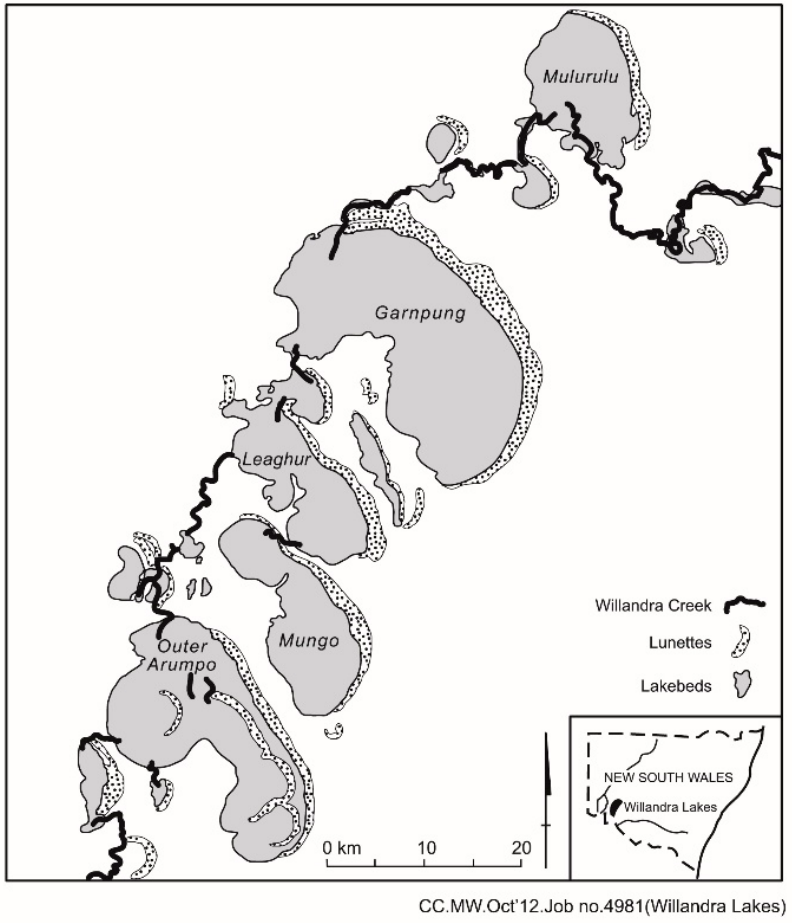
Figure 9. The late Pleistocene Willandra lakes in semi ‐ arid New South Wales, Australia showing Lake Mungo. (After [11] Figure 11.3).